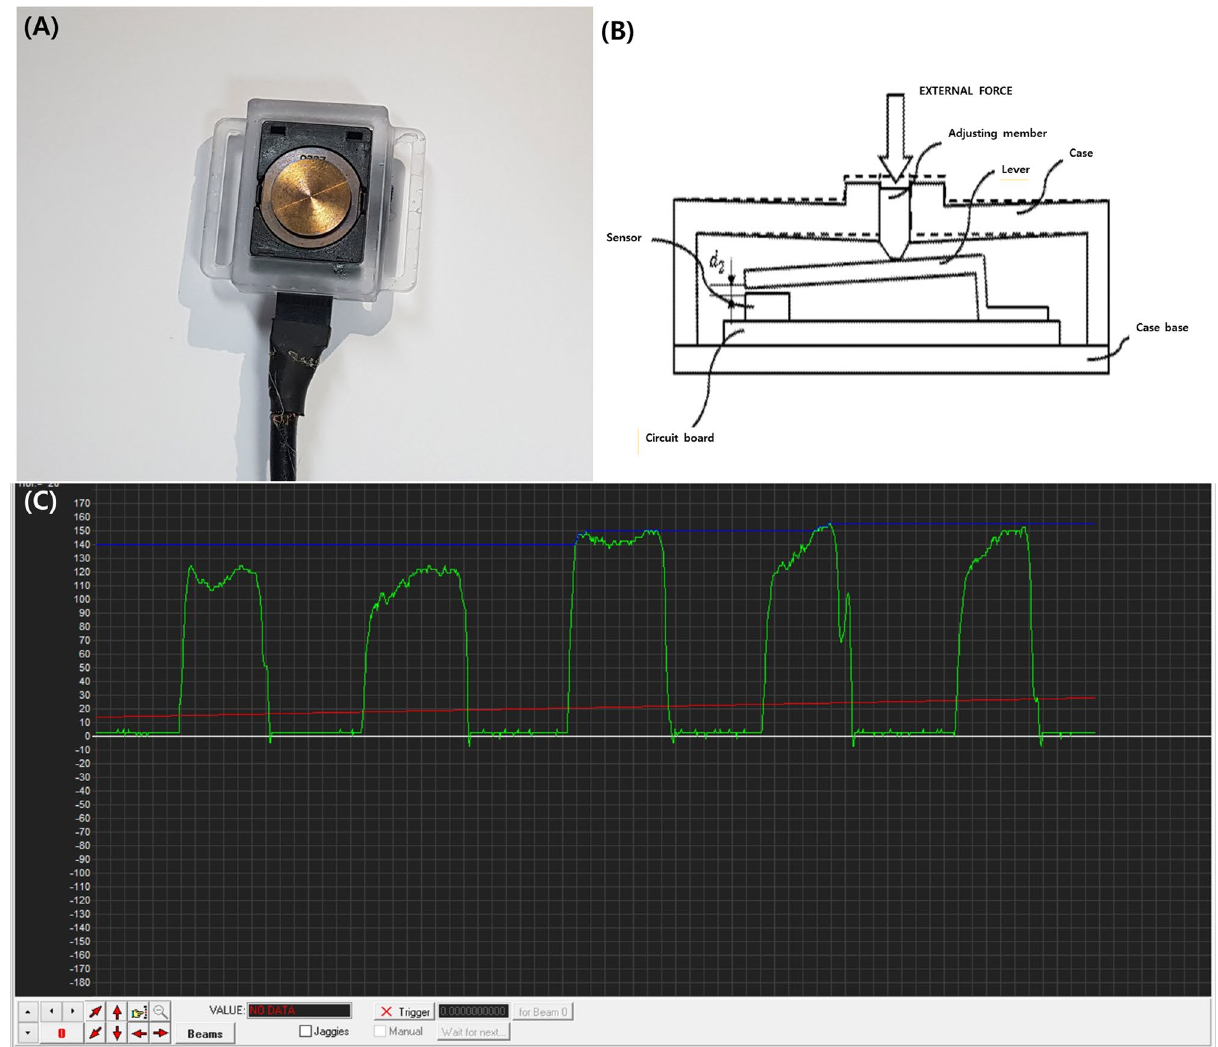
Figure 1. ( A ) Load cell pressure sensor. ( B ) View for explaining an operation mode of the force sensor using a displacement amplification mechanism according to the exemplary embodiment of the present invention. ( C ) Monitoring of pressure sensor during the submandibular push exercise, which used visual